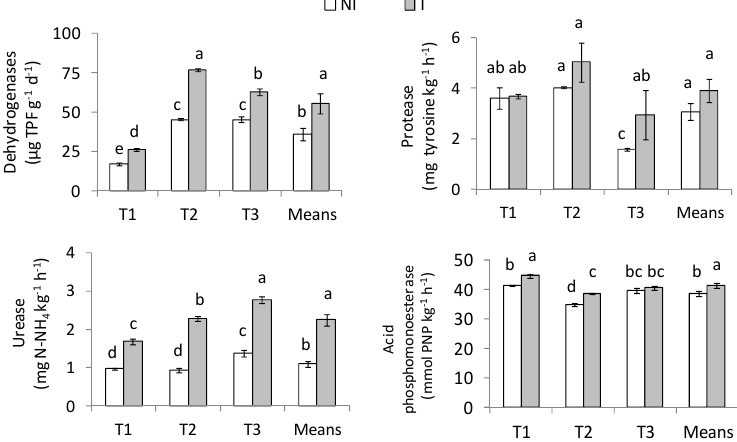
Figure 1. Enzymatic activity. Different lowercase letters indicate significant differences ( p < 0.05). NI, non-inoculated; I, inoculated with Rhizobium ; T1, 5–6 leaf stage; T2, flowering; T3, pod formation stage.